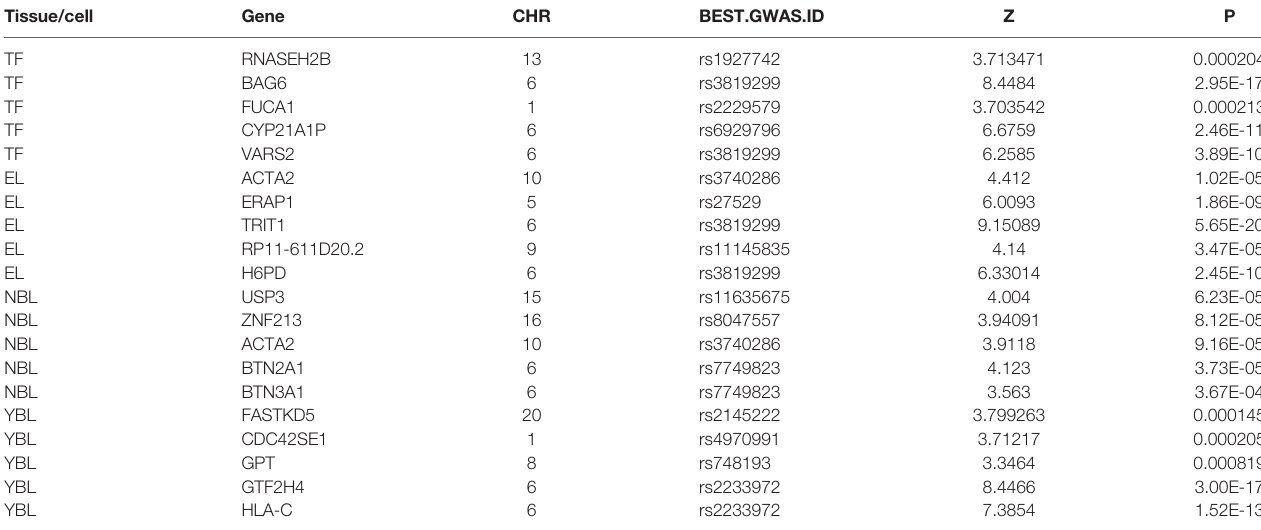
TABLE 2 | AS-signi fi cant expression genes for AS in all 4 tissues. Tissue/cell Gene CHR BEST.GWAS.ID